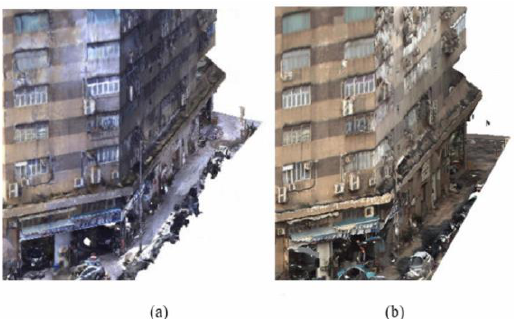
Figure 2. Comparison between mesh models generated without and with color equalization. (a) Mesh model textured with original images. (b) Mesh model textured with processed images.